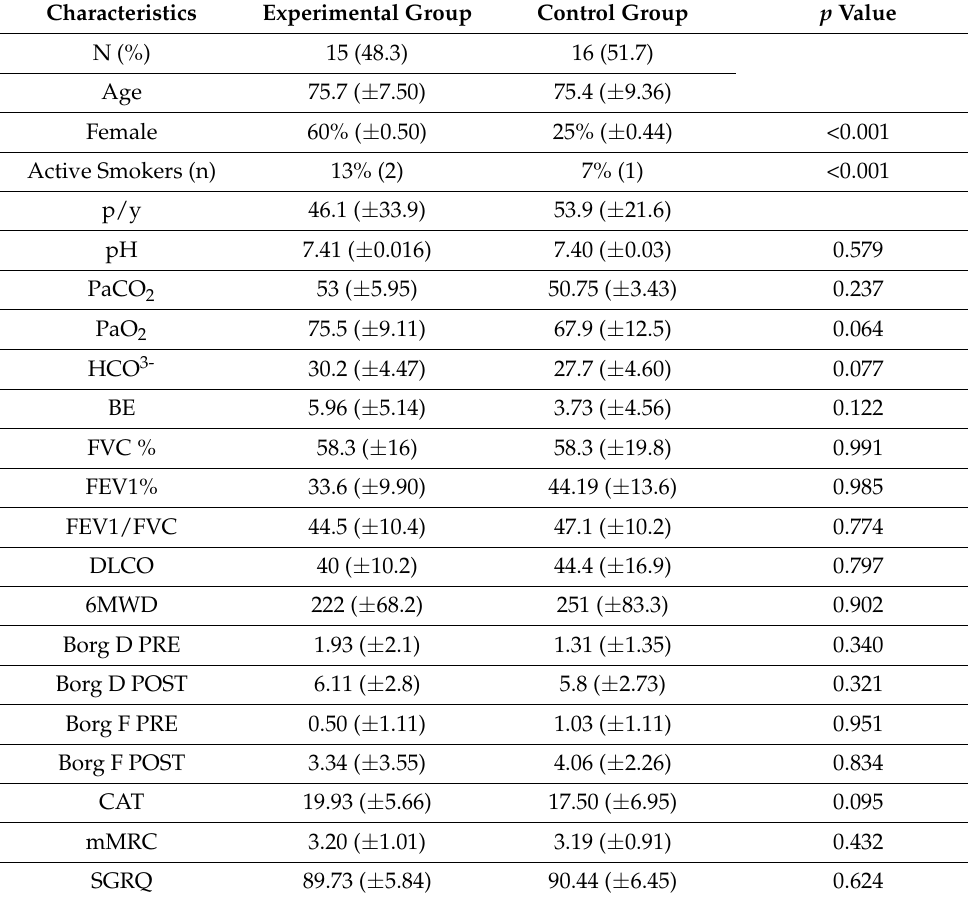
Table 2. Characteristics of patients at baseline. Results are shown as mean ± SD.